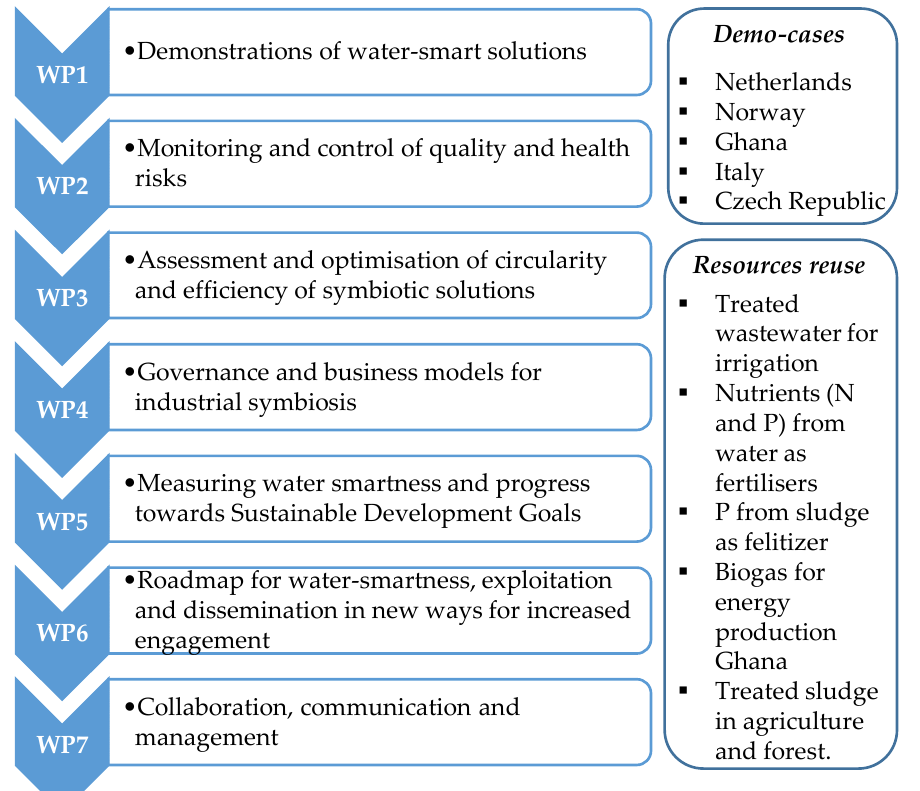
Figure 1. Summary of WIDER UPTAKE WPs, demonstration cases and resources recovery.